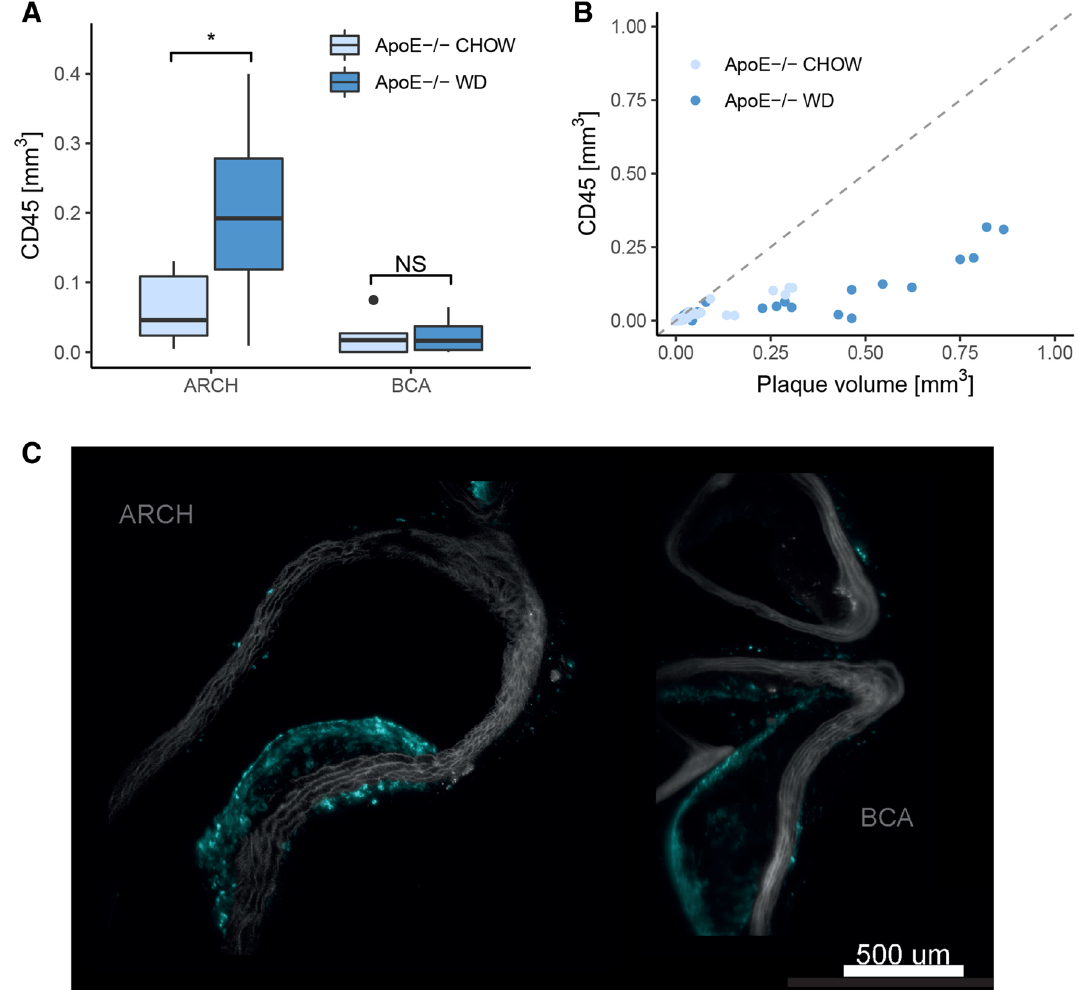
Figure 3. Plaque composition in terms of CD45 signal. ( A ) Immune cell marker CD45 signal in ApoE−/− mice in different vessel compartments. CD45 volume is increased in the aortic arch of ApoE−/− mice on western diet (FDR corrected p value = 0.014), but not in the BCA branch (FDR corrected p value = 0.95). ( B ) Composition of individual plaque objects in terms of CD45 signal and total volume. ( C ) Optical cross section images reveal that CD45 is only found in the periphery of larger plaques. Left image: aortic arch, right image: BCA. Both images are from Apoe−/− mice fed western